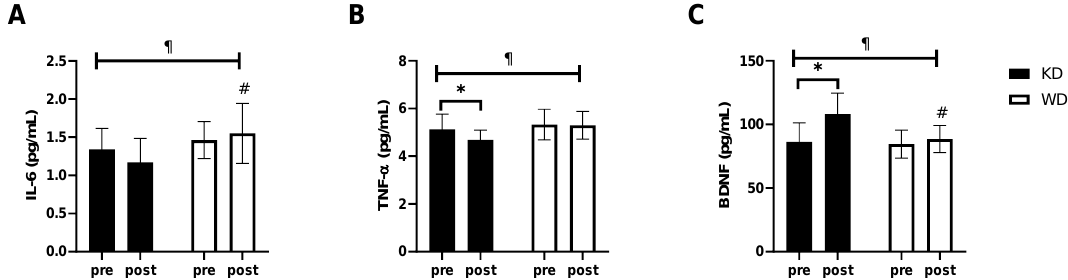
Figure 4. Inflammatory markers and brain-derived neurotrophic factor (BDNF). ( A ) IL-6 concentration; ( B ) TNF- α concentration; ( C ) BDNF concentration. * significantly different from pre-value ( p < 0.05); # significantly different from KD group ( p < 0.05); ¶ time × diet interaction ( p < 0.05). KD, ketogenic diet group; WD, western diet group.